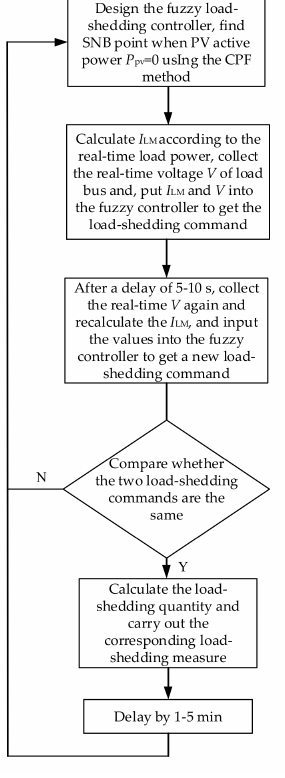
Figure 7. The flow chart of the fuzzy load